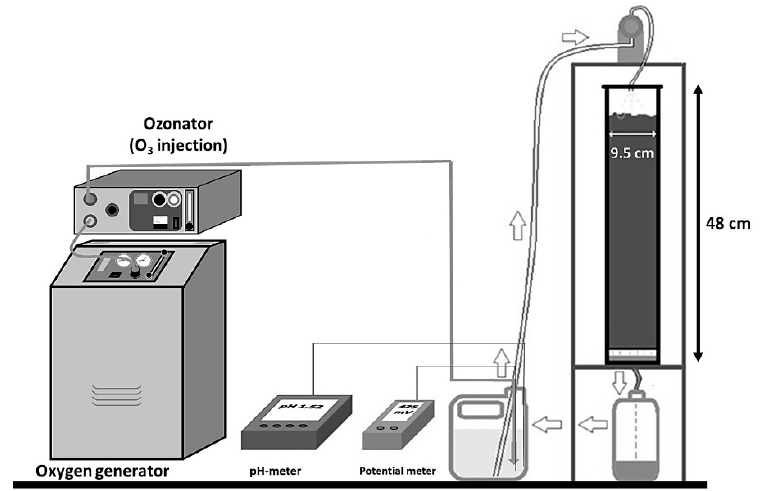
Figure 1. Experimental setup.